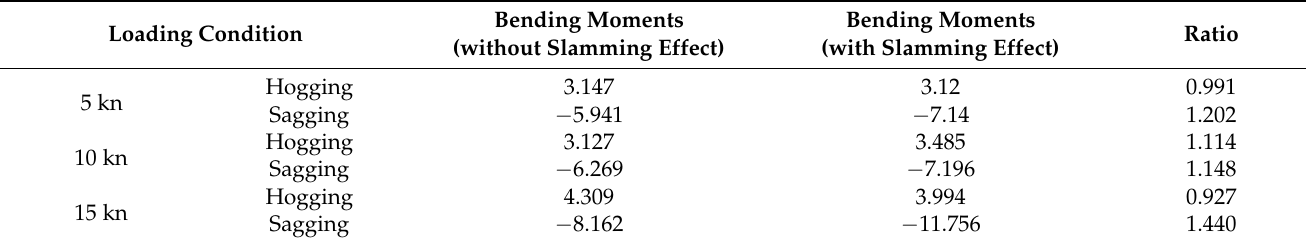
Table 4. Comparison of bending moments (GNm).